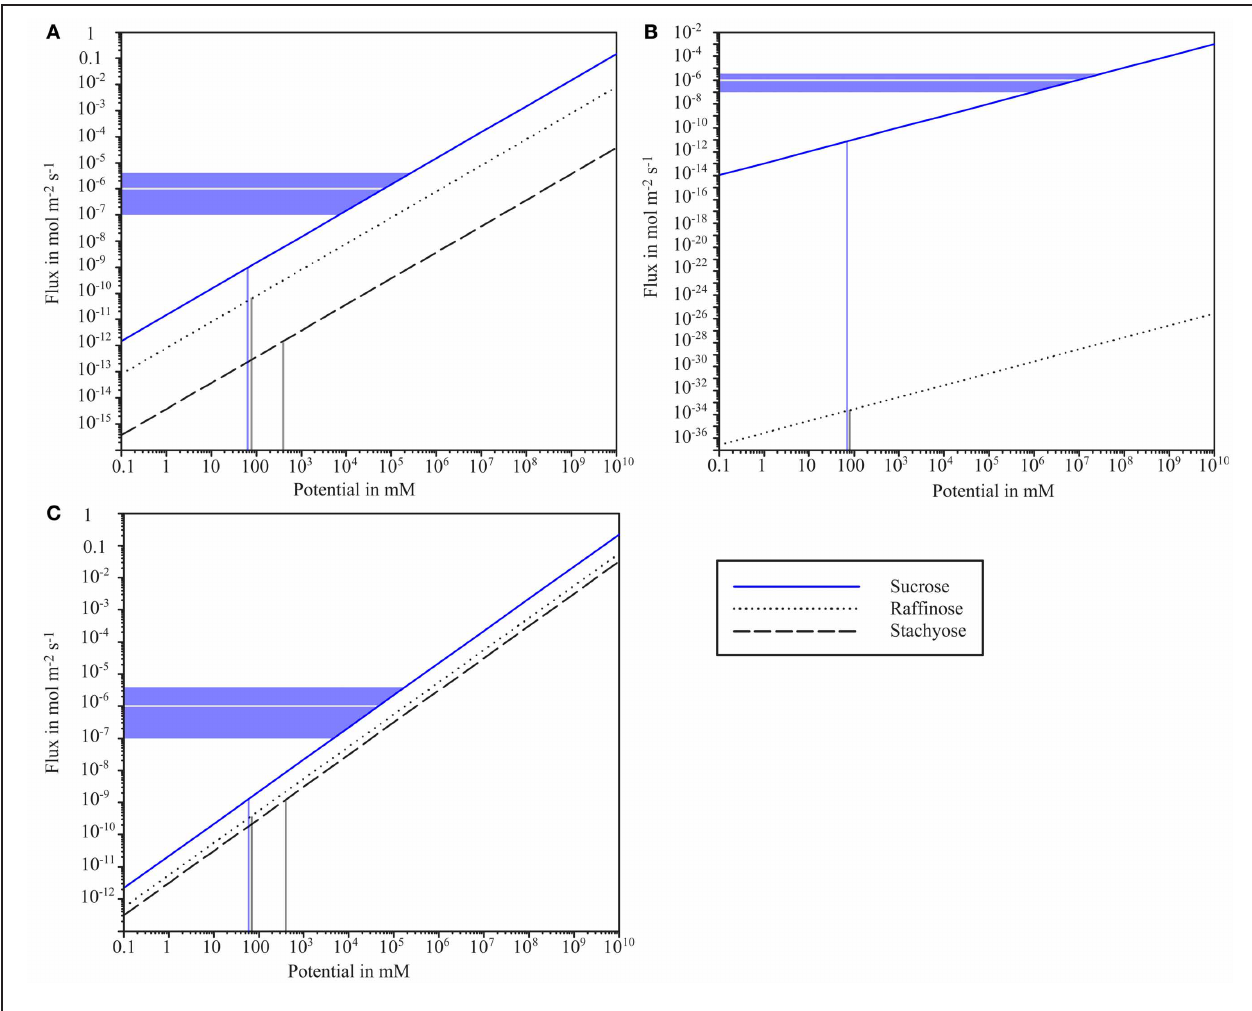
sucrose flux values provided by Schmitz et al. (1987, gray) and a flux range based on values listed in Table 2 (blue). Raffinose flux is strongly hindered in the slit model in contrast to the other configurations, which would enable considerable “leakage” out of the intermediary cell. Hindrance of sucrose flux at concentration potentials observed by Haritatos et al. (1996) would in all models be orders of magnitude too high to realize flux rates reported by Schmitz et al. (1987) and other